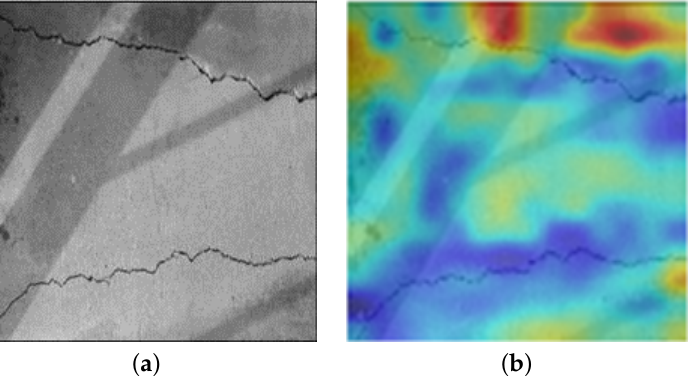
Figure 6. Example of the wrong classification of concrete images with shadows. A concrete image with cracks and shadows from the testing dataset is displayed in the part ( a ); a corresponding Grad-CAM map in presented in the part ( b